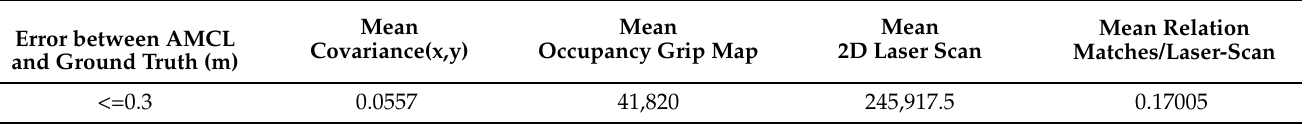
Table 4. Relationship between the ATE, covariance in x and y directions, and matches of occupied grids cells and 2D laser scan points.